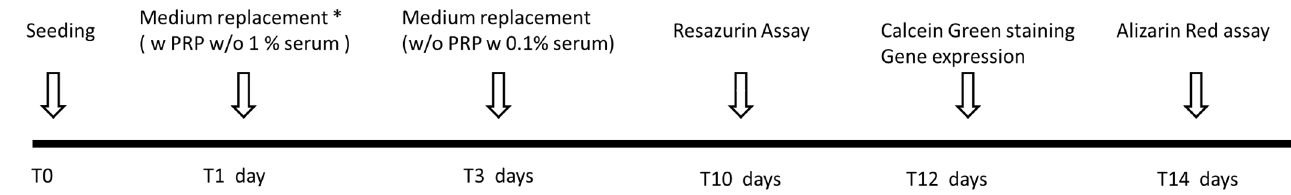
Figure A1. Ratio between the PLTs count and the concentration of GFs [ng/mL] or Fibrinogen [ µ g/mL] released by the PLTs contained in PRP samples.